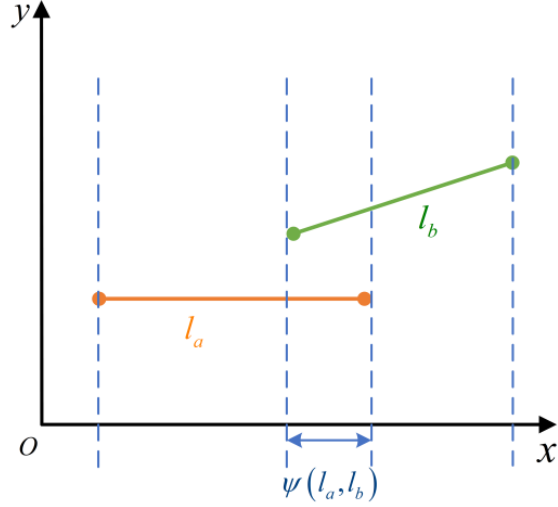
Figure 7. Schematic diagram of the overlap length between two line segments.